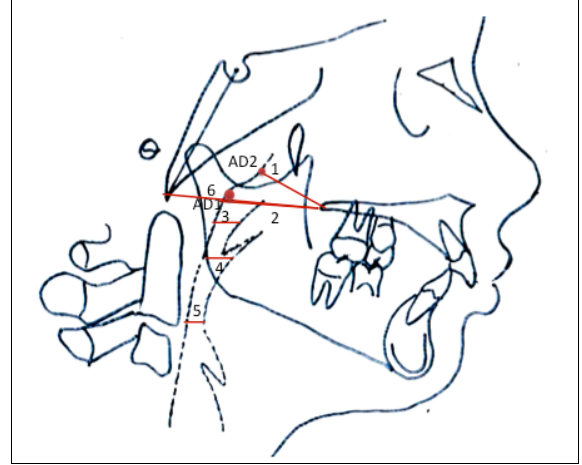
Figure 3. Cephalometric measurements of the upper airway. 1.PNS-AD2 (mm): the distance between PNS and AD2, which is a point on posterior pharyngeal wall intersecting H-PNS line; 2.PNS- AD1 (mm): the distance between PNS and AD1, which is a point on posterior pharyngeal wall intersecting Ba-PNS line; 3.SPAS (mm): the line parallel to horizontal plane between the middle point of PNS and P and posterior pharyngeal wall; 4.MAS (mm): the line extending to anterior and posterior pharyngeal walls from P point; 5.IAS (mm): the line parallel to horizontal plane and passing through the anteroinferior point of CV2 and anterior pharyngeal wall; 6.Ba-PNS (mm): the distance between Ba and PNS